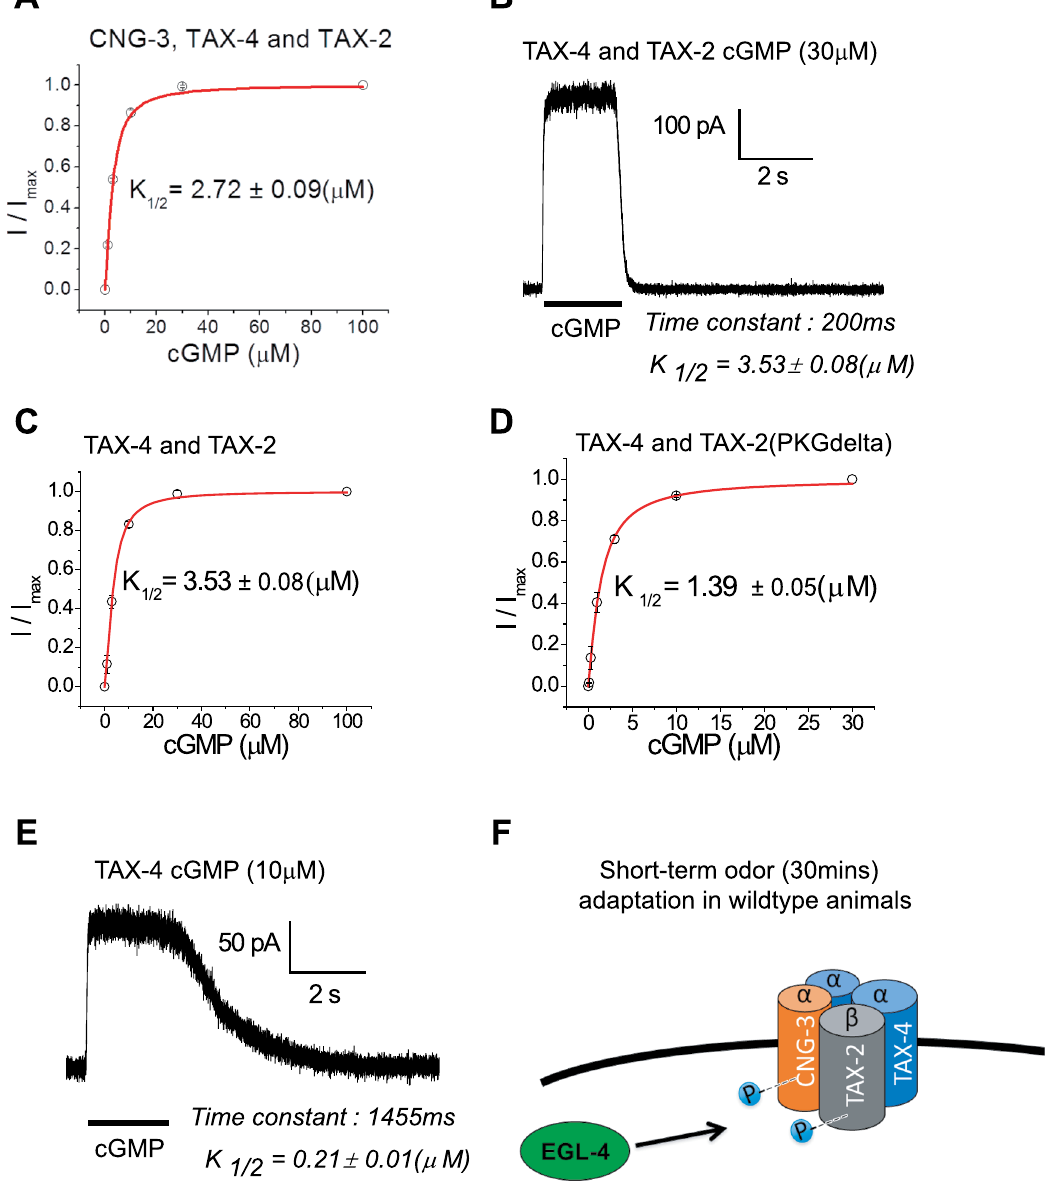
Figure 5. CNG channel subunit composition alters channel gating kinetics. ( A ) CNG subunits were expressed heterologously in human embryonic kidney (HEK) cells. The physiology of HEK cells triply transfected with the CNG channel subunit TAX-2, TAX-4, and CNG-3 was examined and found to exhibit a similar profile to the double transfection of TAX-4 with TAX-2. The K½ for TAX-2/TAX-4/CNG-3 transfected cells was 2.72 µ M. ( B ) Next, the CNG channel subunits TAX-4 and TAX-2 were transfected into HEK cells, and cells expressing both subunits were studied using patch recordings after cGMP application. The double transfected cells exhibit fast opening and closing gating kinetics. ( C,D ) The physiology of HEK cells transfected with TAX-2 and TAX-4 ( C ) were compared with cells that were transfected with TAX-4 and a mutant allele of TAX-2 in which the candidate PKG which was previously shown to be necessary for short-term adaptation is mutated to an Alanine ( D ). The half activation concentration (K½) is reduced from 3.53 µ M to 1.39 µ M of cGMP. ( E ) TAX-4 exhibits a very slow closing kinetics on account of high cGMP affinity. ( F ) A model of the data is presented that suggests a native channel conformation consisting of CNG-3, TAX-2, and TAX-4. TAX-2 has previously been shown to contain a candidate PKG site important for short-term adaptation 19 and here we reveal a candidate PKG site in CNG-3 whose phosphorylation state tunes odor sensitivity in AWC. CNG-3 and TAX-2 may represent targets of EGL-4 at possibly different time scales of the